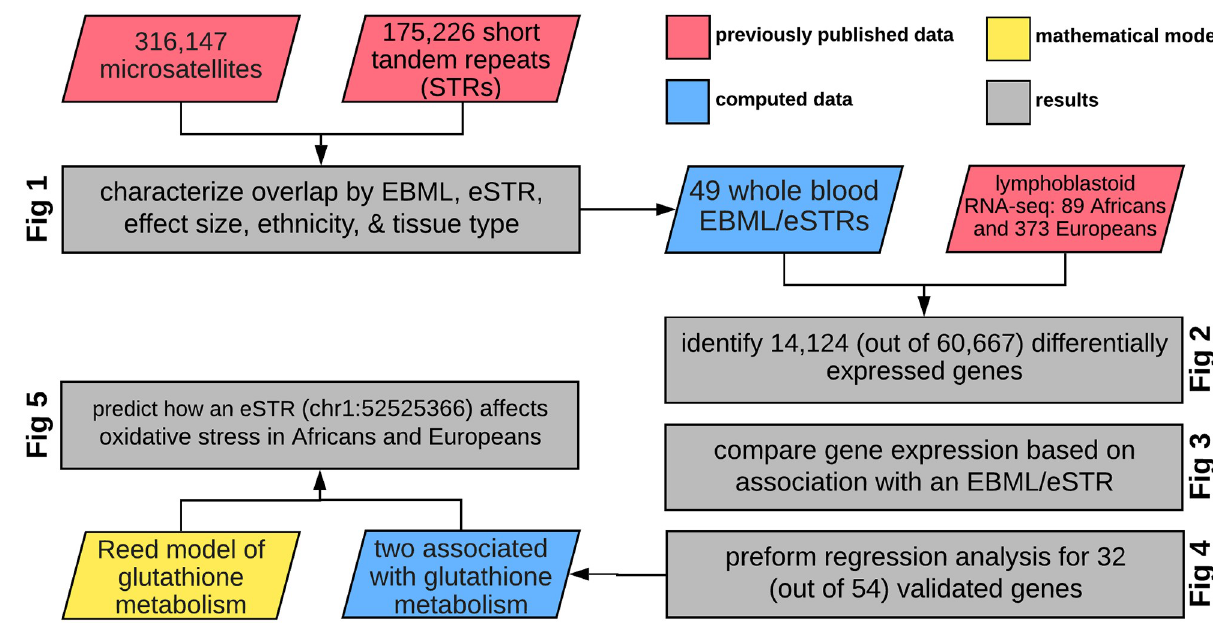
Fig 6. Summary of our overall approach. We characterize 24,304 overlapping regions drawn from two previous studies of short tandem repeats. We validate 32 (out of 54) genes associated with whole blood EBML/eSTRs using RNA-seq: 89 Africans and 373 Europeans. We subsequently quantify their effects on gene expression and perform KEGG pathway enrichment analysis. Two of the validated EBML/eSTRs affect glutathione metabolism. We modify the Reed model to predict how an eSTR associated with GPX7 expression affects response to oxidative stress in Africans and Europeans,